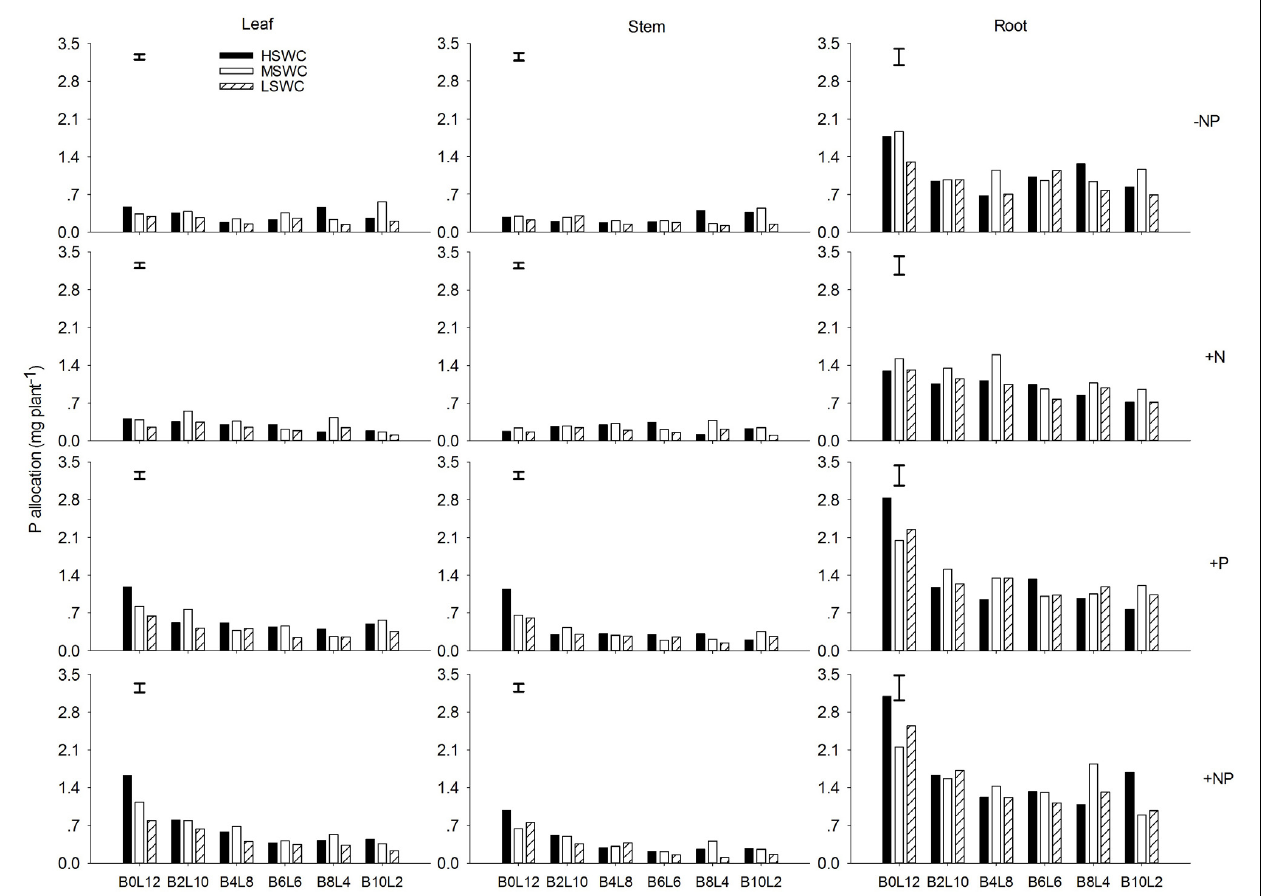
FIGURE 6 | P allocation in leaf, stem and root of L. davurica (L) mixed with B. ischaemum (B) at various mixture proportions under three soil water regimes [HSWC: 80% FC (field capacity); MSWC: 60% FC; LSWC: 40% FC] and four fertilization treatments (–NP, +N, +P, +NP). B i L j ( i , j = 0, 2, 4, 6, 8, 10, 12; i + j = 12) means the plant numbers of B. ischaemum to L. davurica in their mixtures. Error bars are LSD ( p <